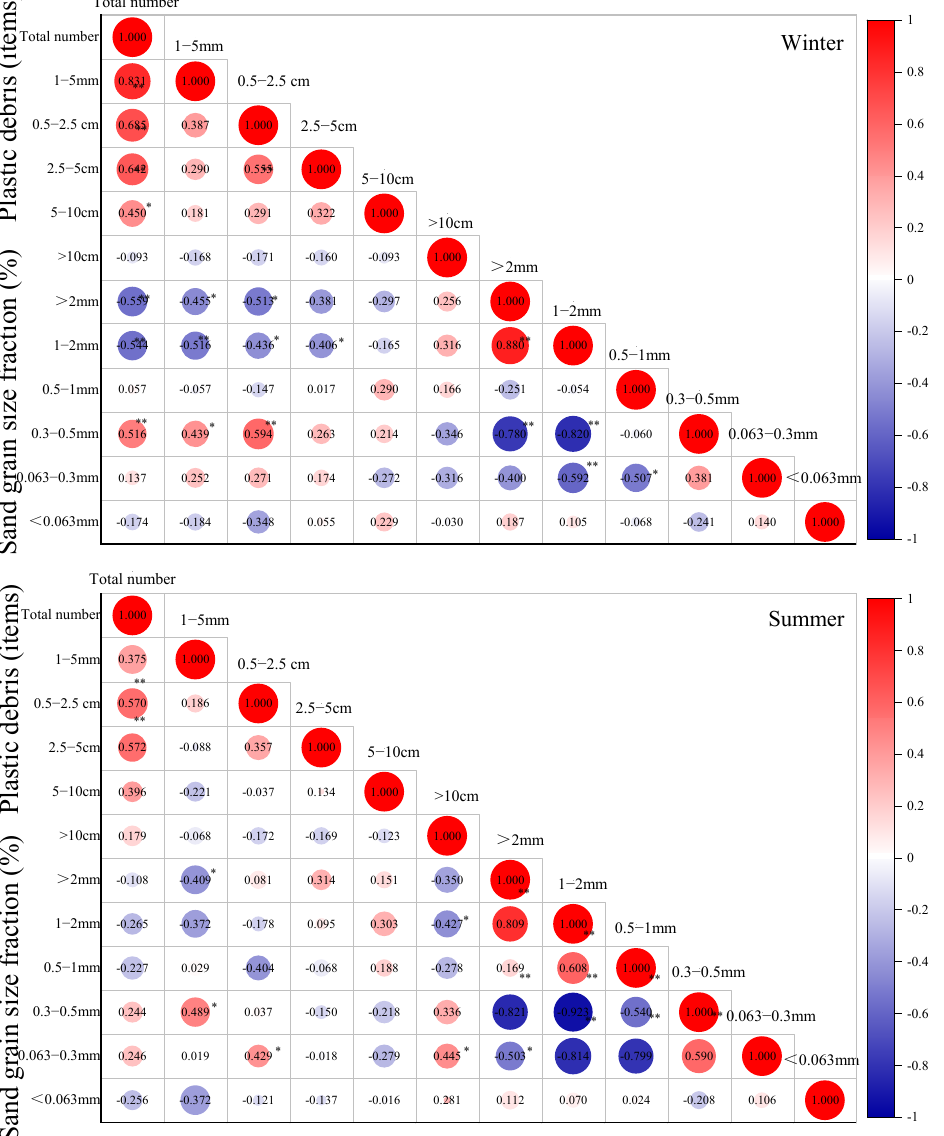
Figure 6. Spearman correlation coefficients between the items of plastic debris by size and sand grain size fraction ( n = 24). Note: * refers to correlations significant at p < 0.05 (two ‐ tailed) and ** refers to correlations significant at p < 0.01 (two ‐ tailed).